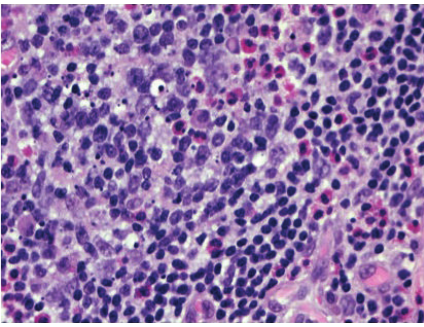
Figure 6: Eosinophils within germinal centers (H&E staining, 400x).